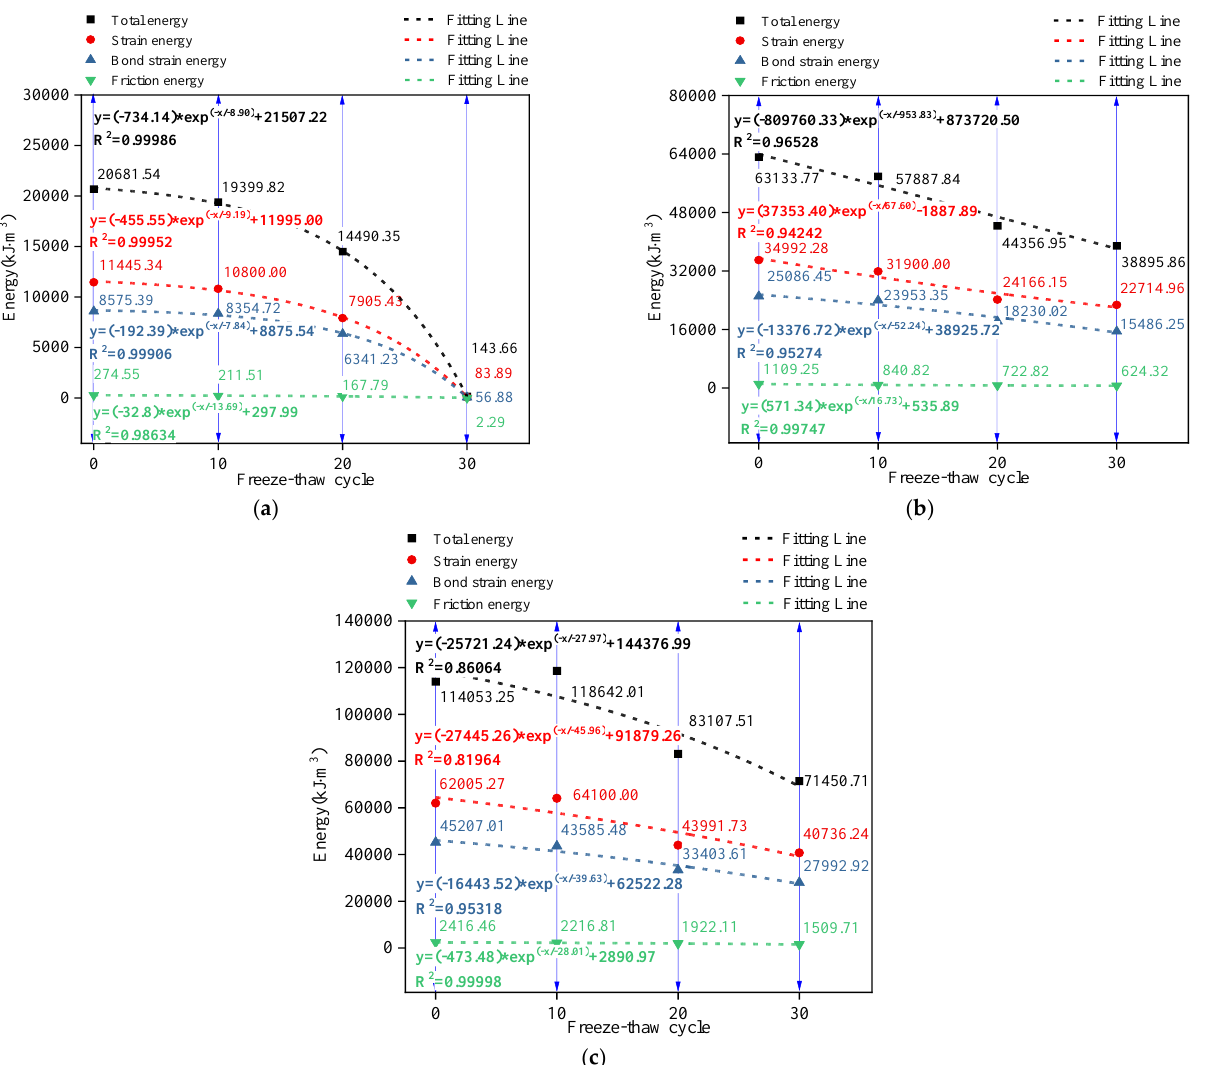
Figure 11. The intrinsic relationship between the number of freeze-thaw cycles and different types of energy: ( a ) 0.44σ c ; ( b ) 0.75σ c ; and ( c ) σ c .